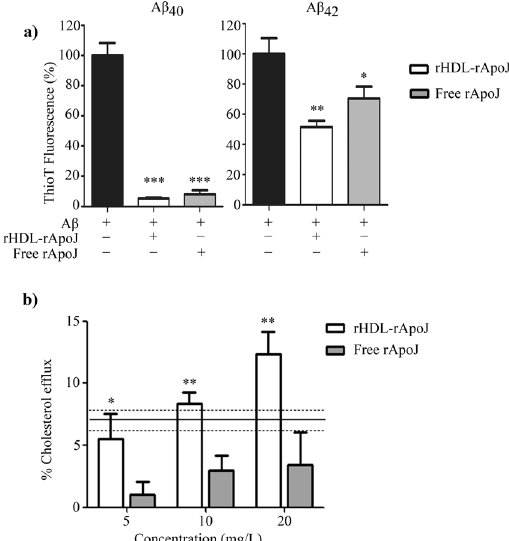
Figure 4. rHDL-rApoJ in vitro functionality. ( a ) Thioflavin T binding assay: ThT fluorescence intensity of A β 42 and A β 40 after 24 h at 37 °C with rApoJ or rHDL-rApoJ. Concentration ratio A β : free rApoJ/rHDL-rApoJ 1:0.01 (N = 4). One way ANOVA and Dunnett’s post hoc test: ** p < 0.001, * p < 0.01 compared to control condition. (b) [ 3 H] Cholesterol efflux removal from J774A.1 cells by rHDL-rApoJ and free rApoJ. The reference line indicates the mean ± SEM of the value obtained using ApoA-I (N = 3). t-test analysis: * p < 0.05, ** p < 0.01 comparing free ApoJ vs. rHDL-rApoJ at each tested